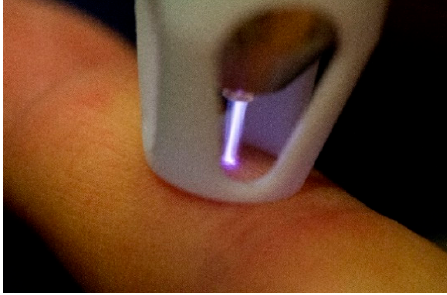
Figure 1. The kINPen ® MED with spacer on skin.